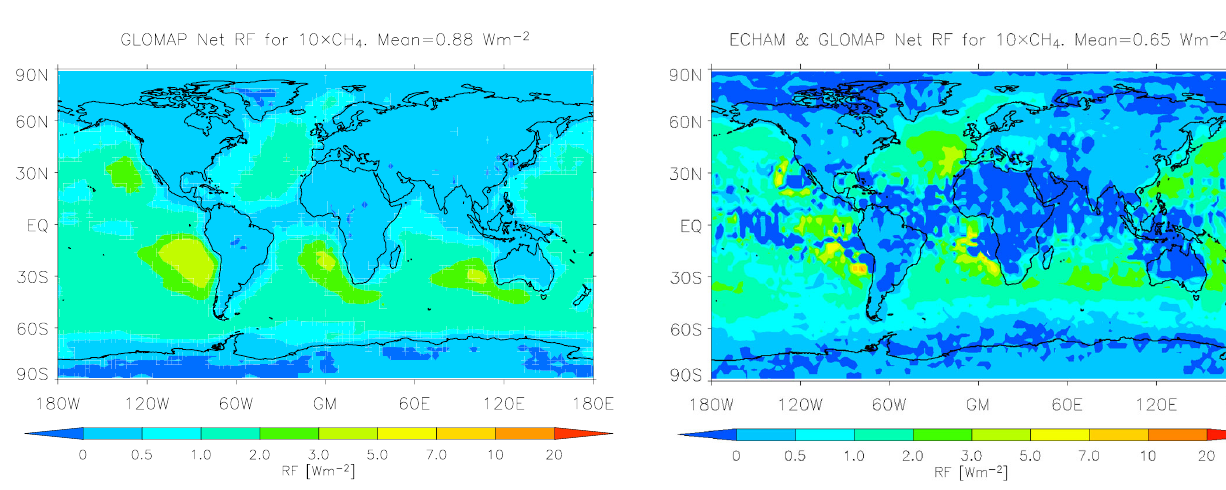
Fig. 7. Predicted cloud-albedo aerosol radiative forcing (in Wm − 2 ) associated with a CH 4 concentration increased by a factor of 10, using GLOMAP and E-S with ECHAM CDNC fields.